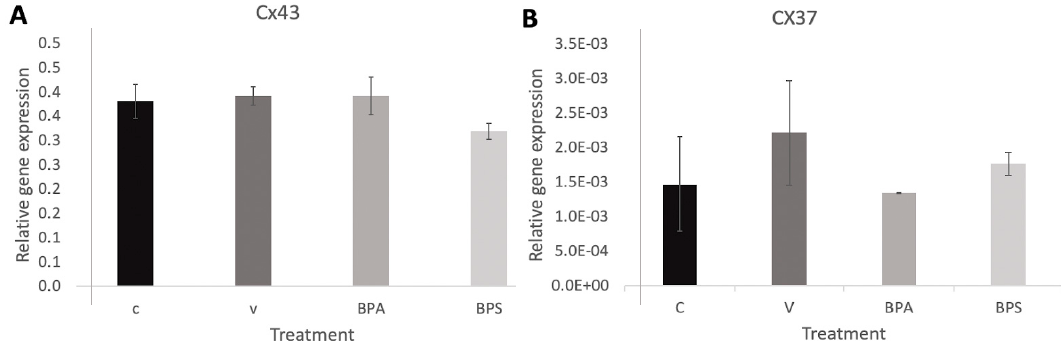
Figure 3. Connexin mRNA expression in bovine COCs. ( A ) CX43 and ( B ) Cx37mRNA expression in bovine COCs after 24 h of maturation in S-IVM (C), S-IVM and 0.1% ethanol (V), S-IVM and 0.1% 0.05mg/mL (BPA), S-IVM 0.1% 0.05mg/mL (BPS), N = 3.